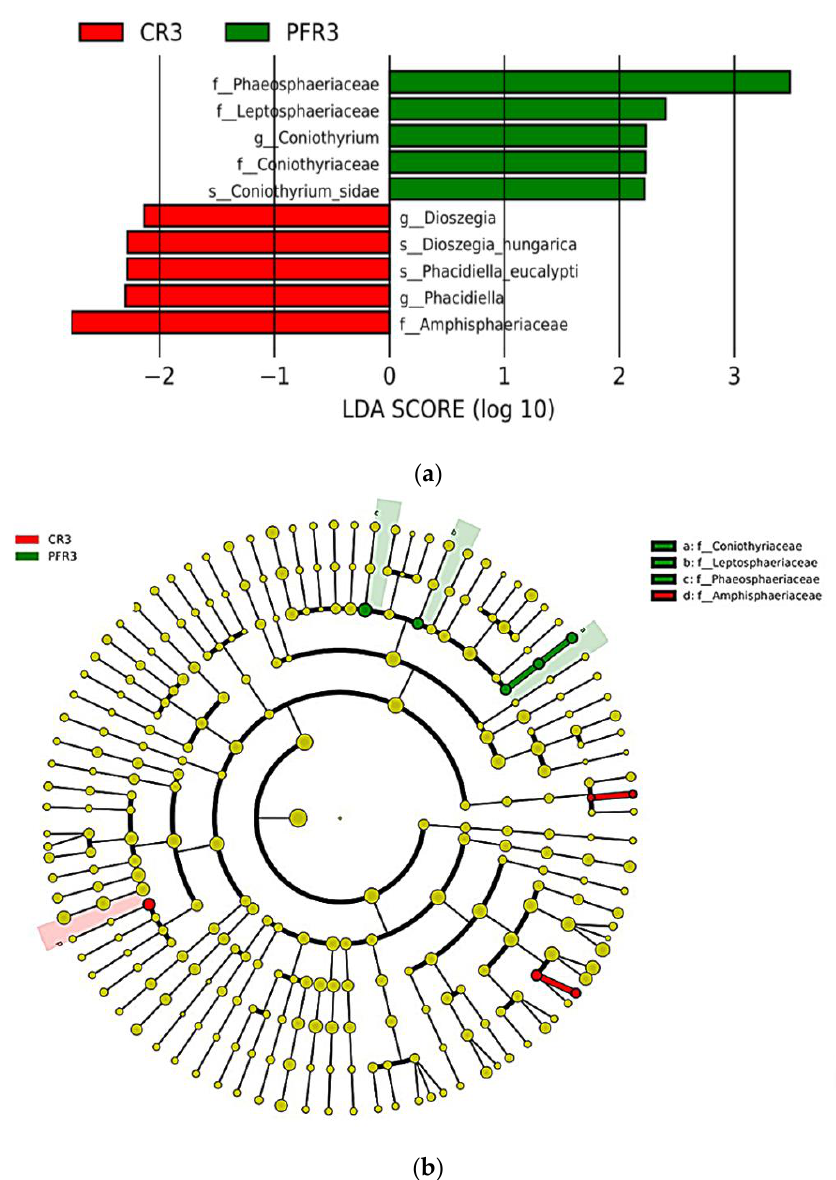
Figure 8. LEfSe analysis illustrating the differences in relative abundance of the taxa of calyx-end and peel tissues of unbagged apple fruit. ( a ) The linear discriminant analysis (LDA) histogram exhibits biomarkers of fungal microbiota of unbagged apple fruit. The histogram shows 10 taxonomic clades of fungal taxa with significant differences (cut-off score ≥ 2.0). ( b ) The cladogram with significantly discriminant taxon nodes colored. Red and green circles mean that taxa show differences in relative abundance, and yellow circles mean non-significant differences; branch areas are shaded according to the highest ranked group for that taxon.